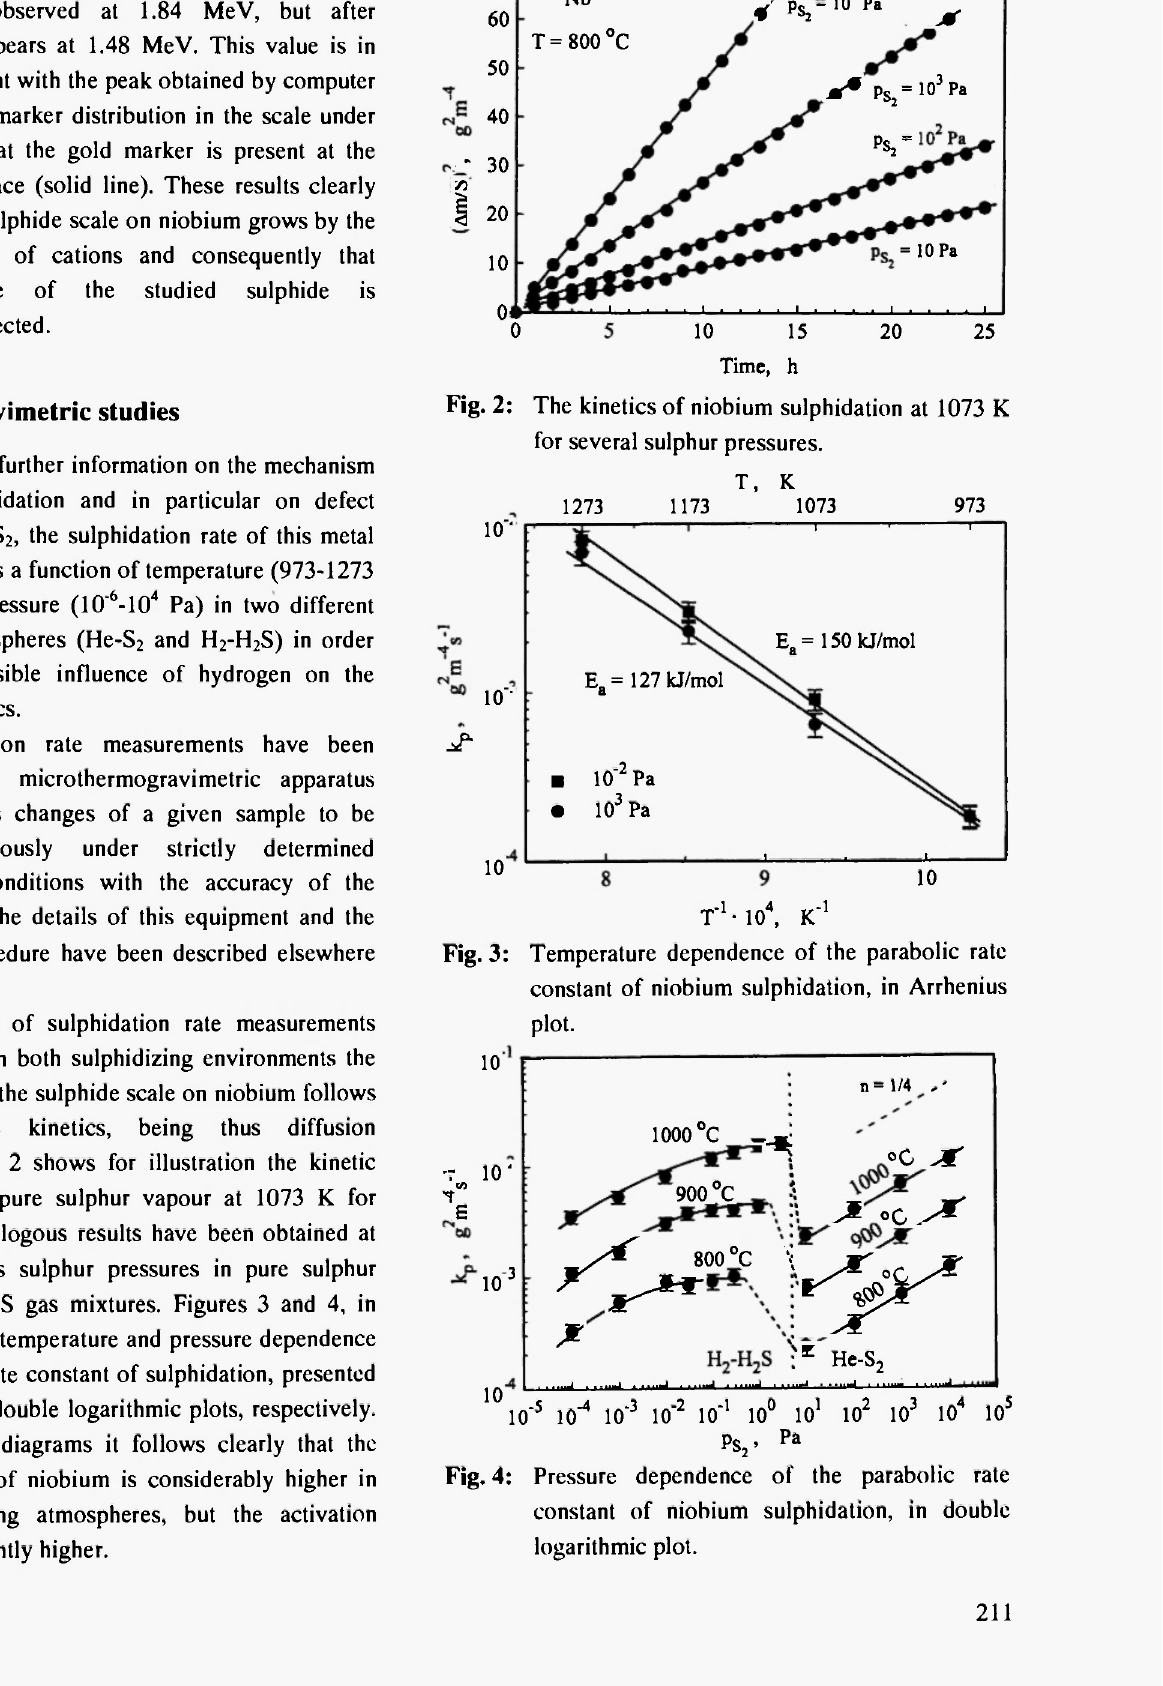
Fig. 2: The kinetics of niobium sulphidation at 1073 Κ for several sulphur pressures.